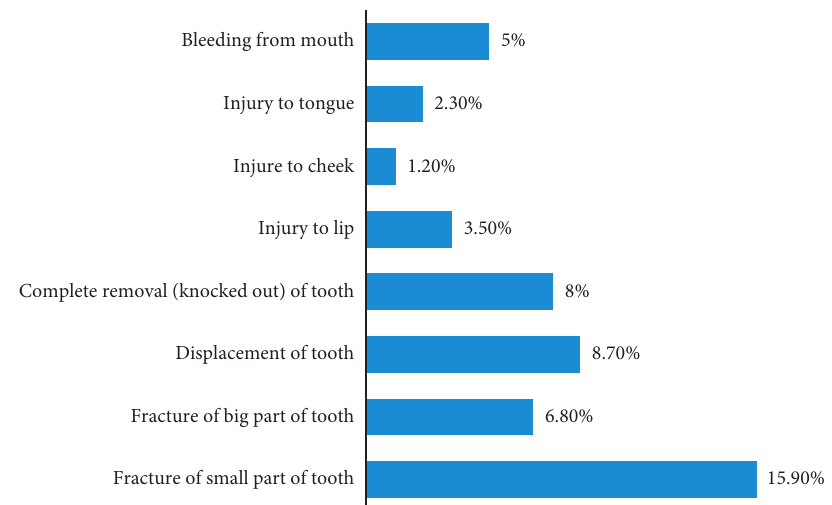
Figure 1: Distribution of participants’ responses about the types of dental trauma and oral